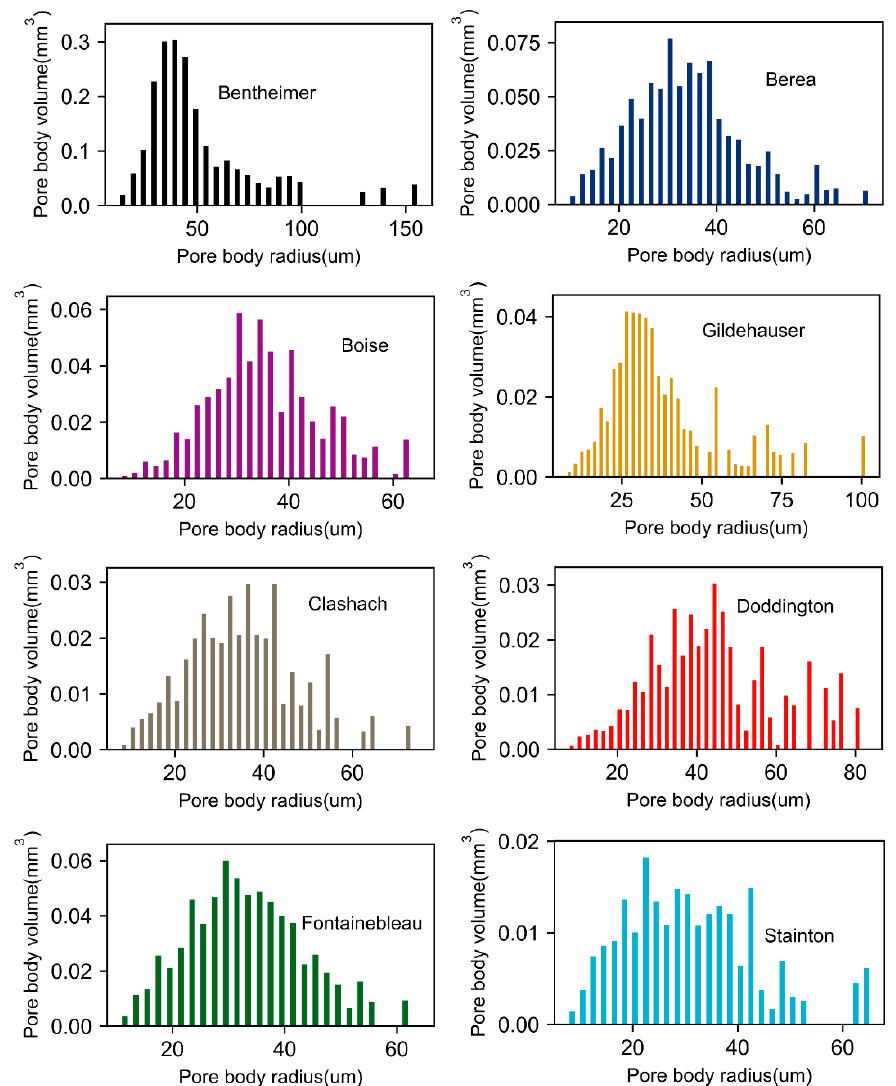
Figure 6. The distribution histogram of equivalent pore radii for the sandstone samples.